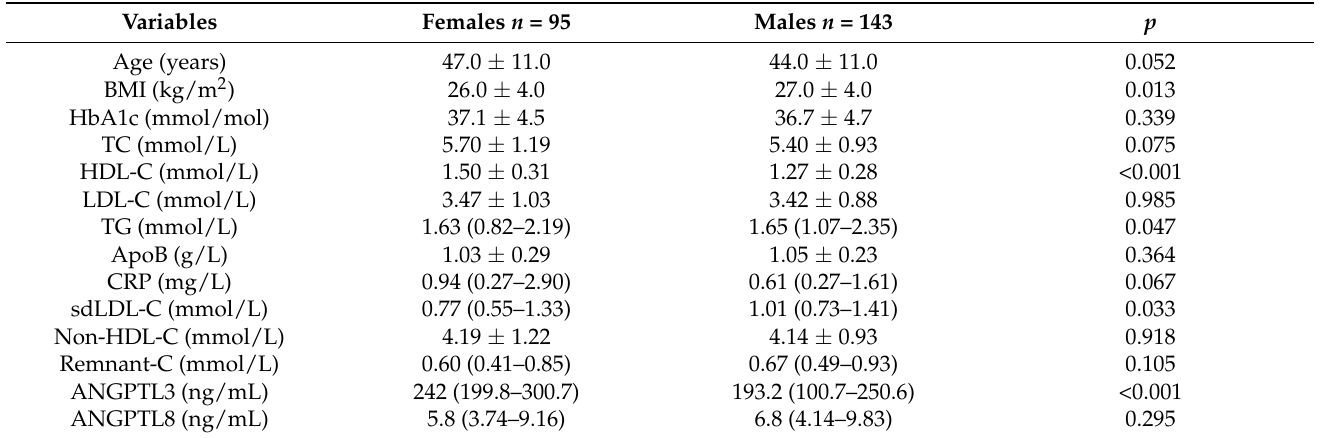
Table 1. General characteristics of study participants by gender.